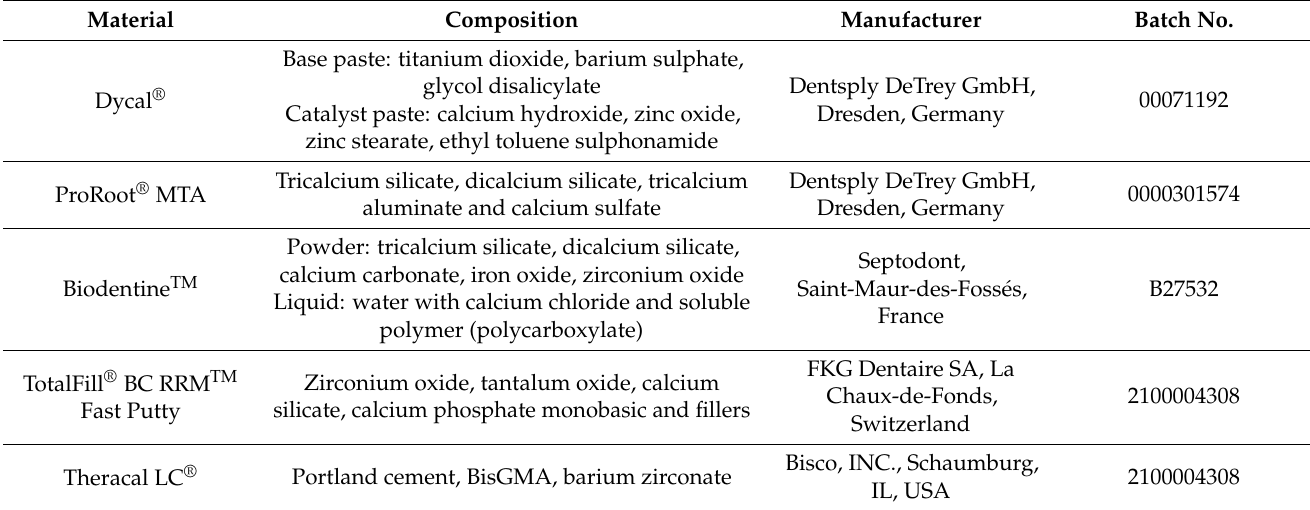
Table 1. Calcium silicate-based cements used and respective compositions, manufacturers, and batch